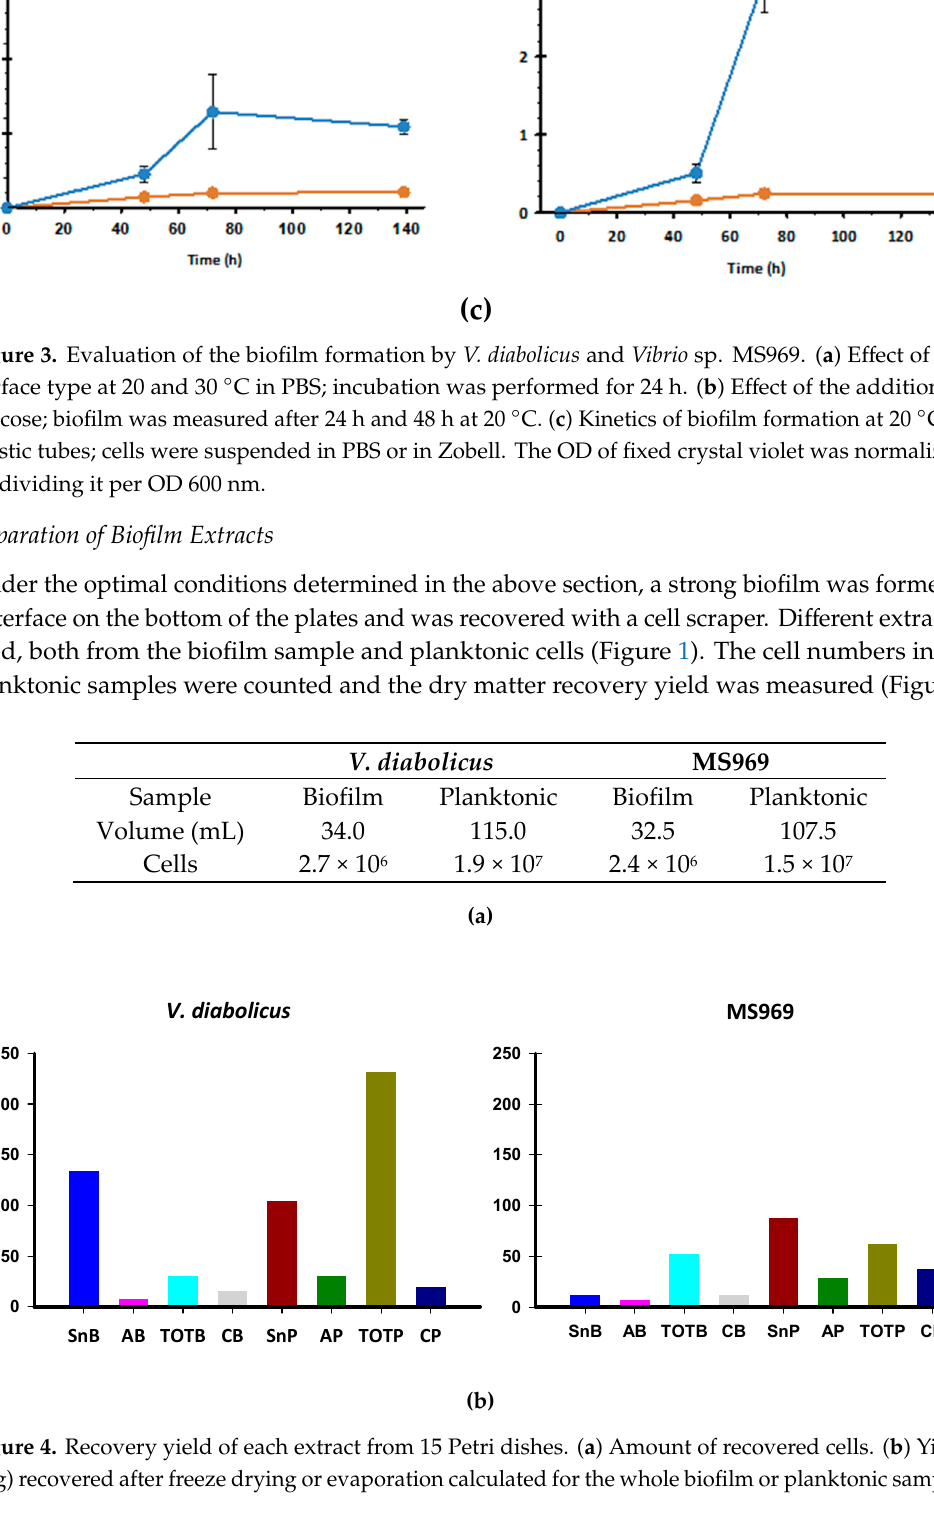
Figure 3. Evaluation of the biofilm formation by V. diabolicus and Vibrio sp. MS969. ( a ) Effect of the surface type at 20 and 30 °C in PBS; incubation was performed for 24 h. ( b ) Effect of the addition of glucose; biofilm was measured after 24 h and 48 h at 20 °C. ( c ) Kinetics of biofilm formation at 20°C in plastic tubes; cells were suspended in PBS or in Zobell. The OD of fixed crystal violet was normalized by dividing it per OD 600 nm.